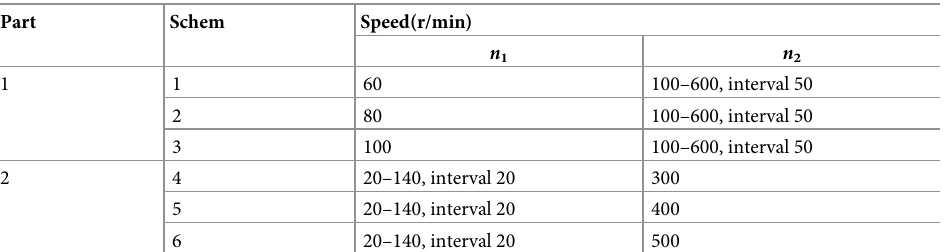
Table 2. Experiment parameters.